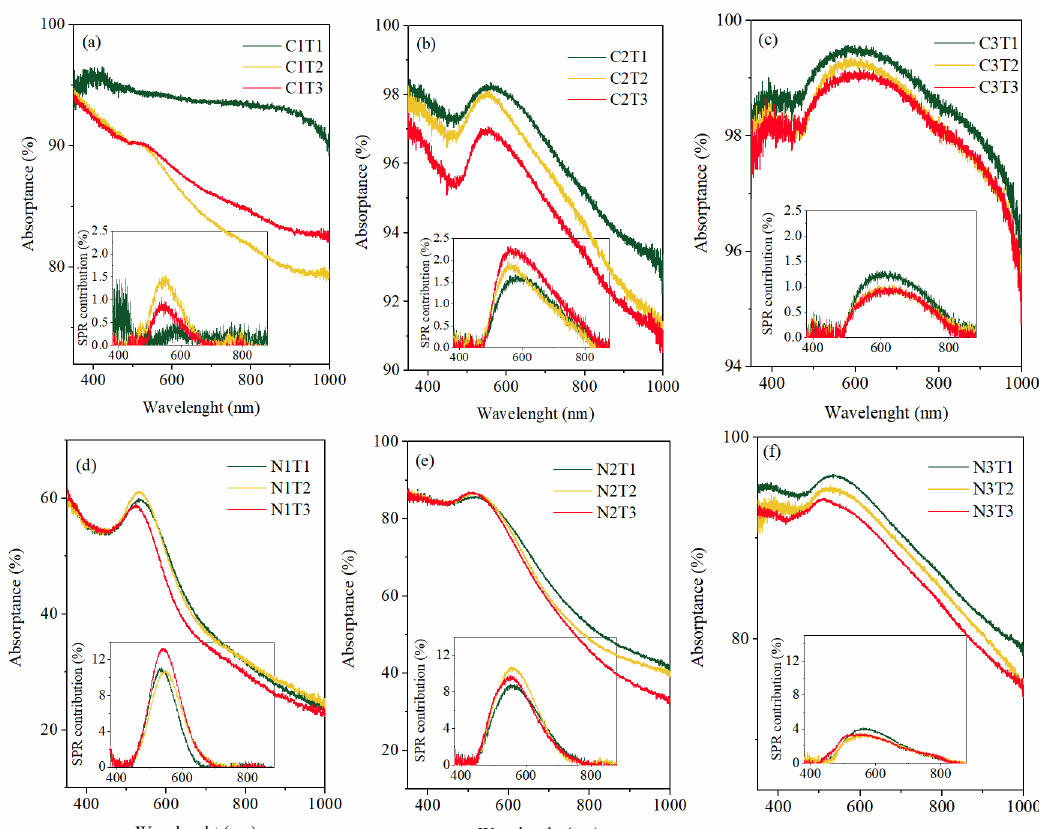
Figure 4. Optical properties of the films. Absorptance vs. wavelength for Au NPs in ( a – c ) SiC and ( d – f ) Si 3 N 4 matrices. The insets show the SPR contribution in the absorptance. The x-scale in insets also represents the wavelength in nm. Table 3. Parameters of the SPR contribution to the absorptance spectra. The peak position, its full width at half maximum (FWHM) and its maximal intensity (Peak max.) are shown. The unit of the maximum of the peak is percentage of the absorptance.